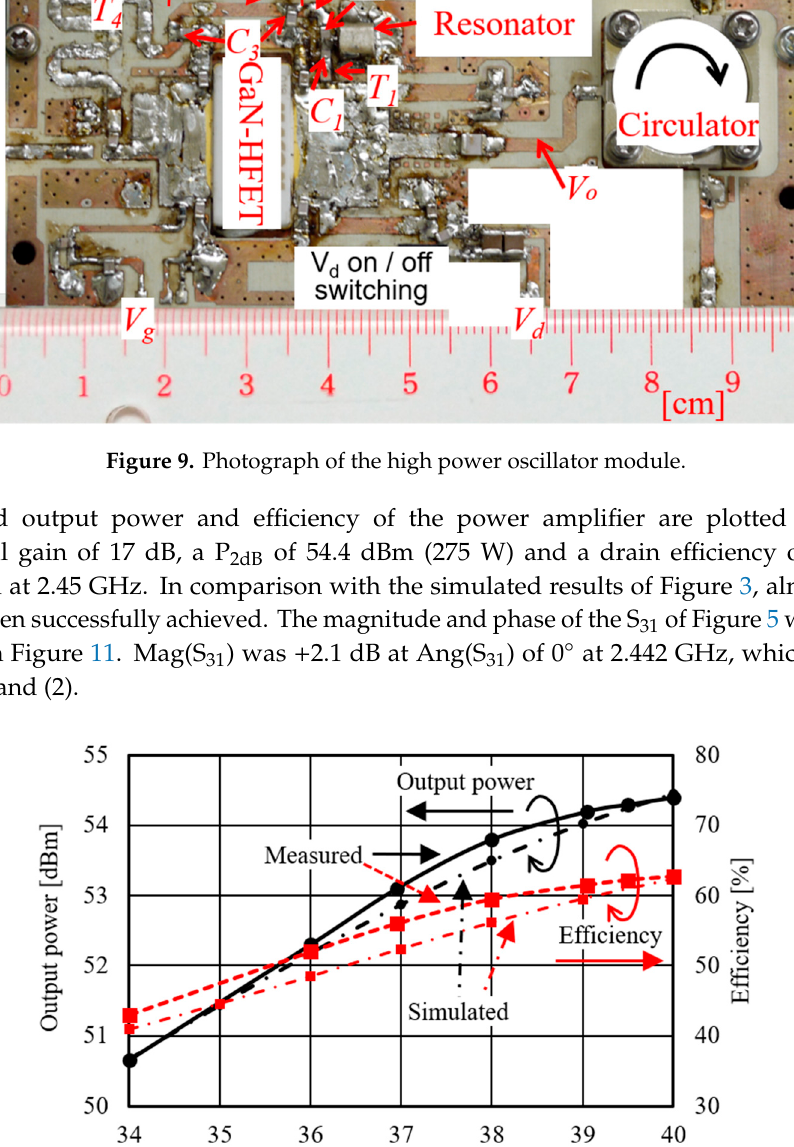
Figure 11. Measured magnitude and phase of the S 31 of Figure 5. The measured output power and efficiency of the module with the circulator are plotted in Figs. 12. V d was varied from +45 to +50 V. As V d increases, the output power, and the oscillation frequency increase. The efficiency, however, keeps around constant for V d of +45 to +50 V. In the case with the circulator of Figure 12, an output of 54.2 dBm (263 W), an efficiency of 61.3%, and an oscillation frequency of 2.44 GHz were obtained at a supply voltage of +50 V. Now it is assumed that the insertion loss of the circulator is 0.15 dB. Then the output power and drain efficiency before the circulator become 54.4 dBm (275 W) and 63.5% at V O in Figure 9, respectively, which are in good agreement with the measured power amplifier results.